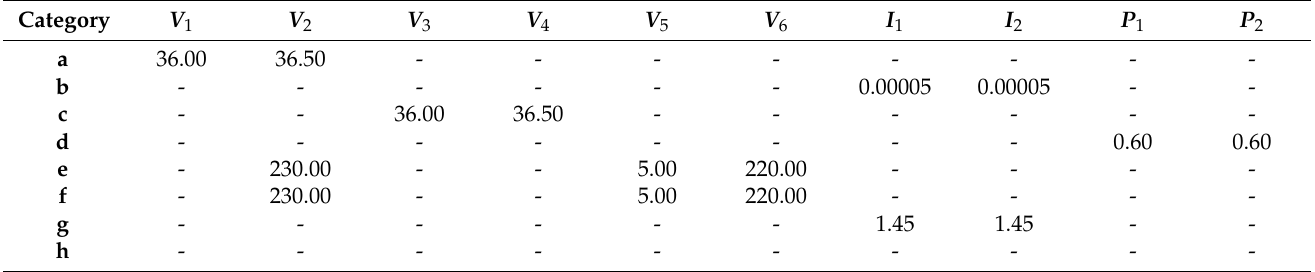
Table 5. Corresponding voltages, currents and power used in the calculations of the aging